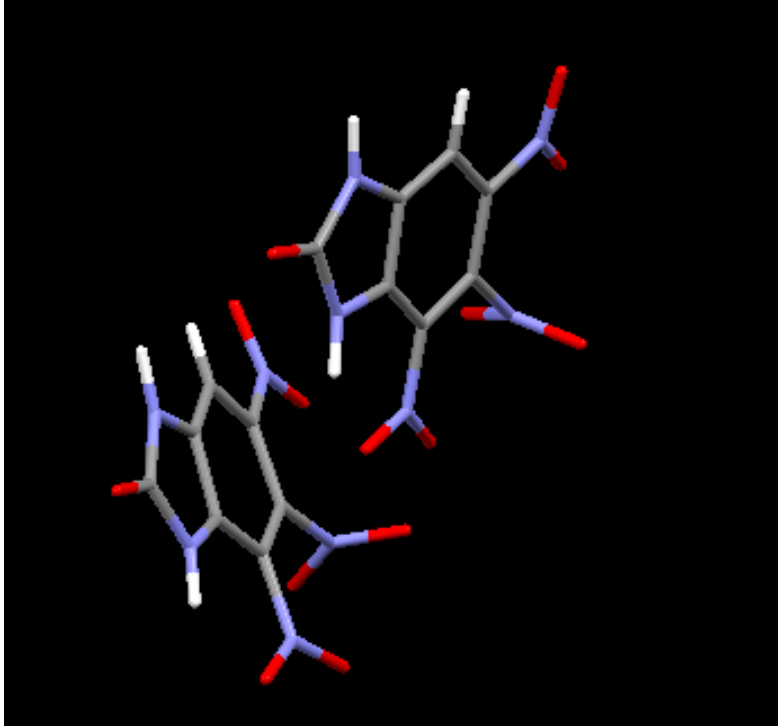
Figure 5. 3D-TriNBO-crystal cell packing image that was obtained from the Mercury program (illustrated hydrogen bonding possibility among neighbor –NH- and -NO 2 functional groups). Hydrogen bonding is an important factor of the high density of this trinitrocompound.